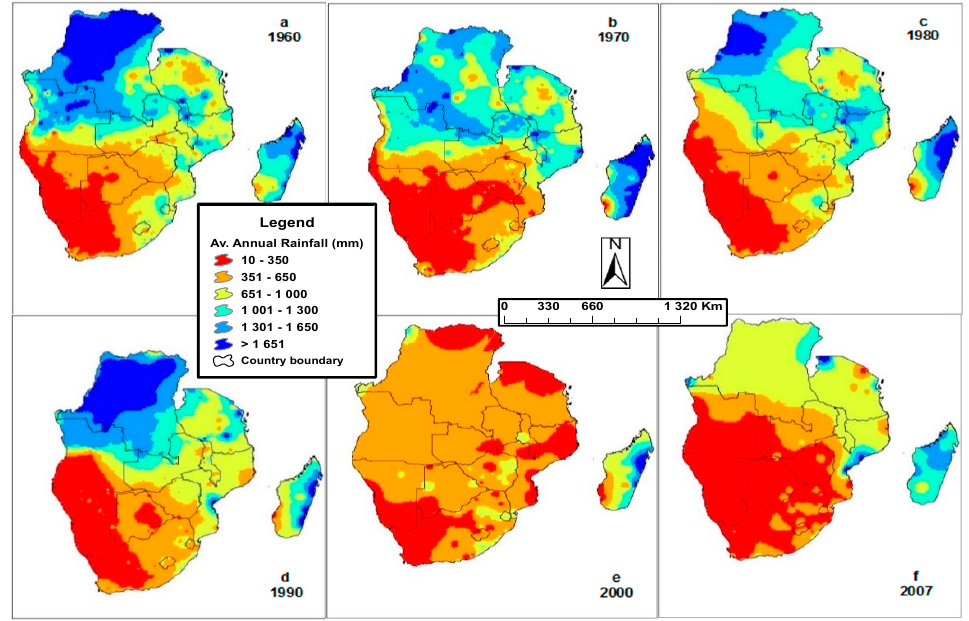
Figure 3. Spatio-temporal changes in rainfall distribution and pattern in Southern Africa over time from 1960 to 2007 ( a – f ). Rainfall has drastically reduced in the most recent years (from 1990 to 2007). There is a noted decreasing trend in rainfall except for islands and countries closer to the Equator where rainfall totals tend to be constant over the years. The general trend and changing pattern in rainfall indicates the high rainfall variability, with incidences of floods and droughts [25]. Examples of extreme weather events are the 1991 / 92 and the 2015 / 16 droughts [30,31] and the 2002 floods [32]. Table 2 presents the country-wise rainfall trends of SADC countries from 1960 to 2007. The trends indicate that rainfall is highly variable in the region. The intensity in rainfall variability is more pronounced in the most recent years. This is shown by the coe ffi cient variation values of annual rainfall (Table 2), which is highest at 0.71 in 2007 compared to 0.45 in 1960. The country wise plot of annual rainfall over the years shows that total annual rainfall for most of the countries has been decreasing in the region as indicated by the negatives in percentage changes in most countries of the region from 1980 to 2007. The decreasing annual rainfall is a major contributing factor to the worsening water scarcity in the